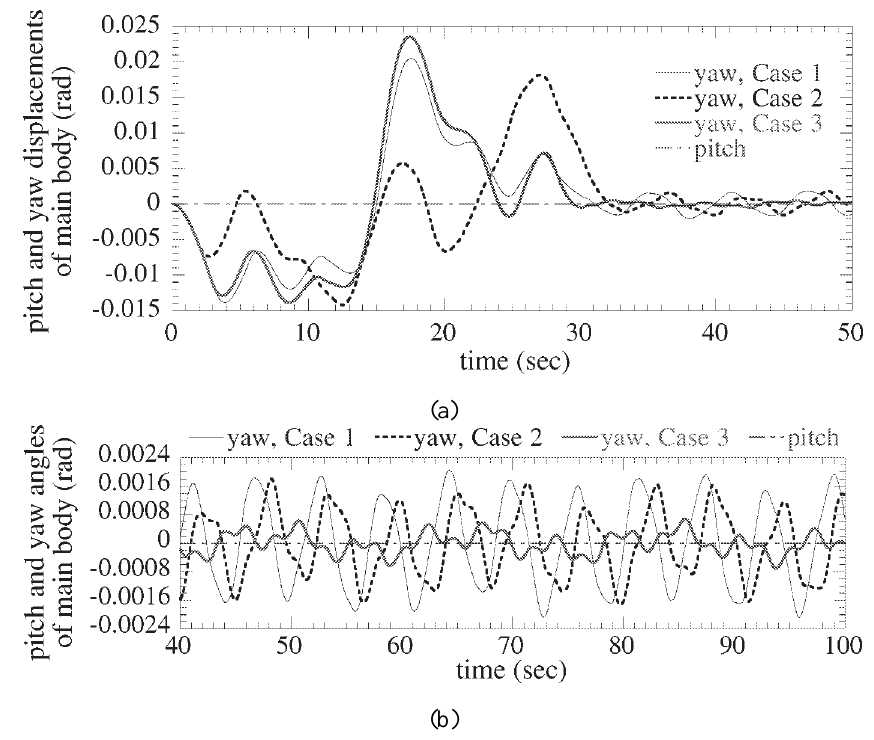
Fig. 10. Time responses of pitch and yaw angle displacements of the main body: (a) during maneuver, (b) residual